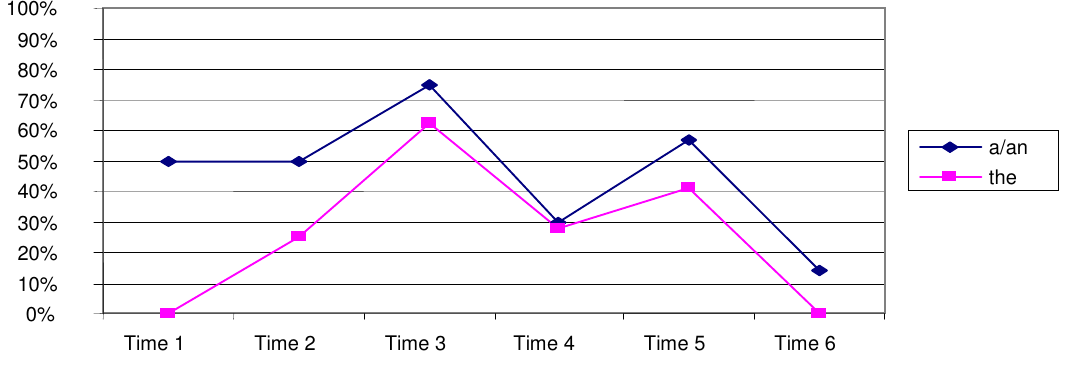
Percentage of Target-like Occurrence of a/an and the across